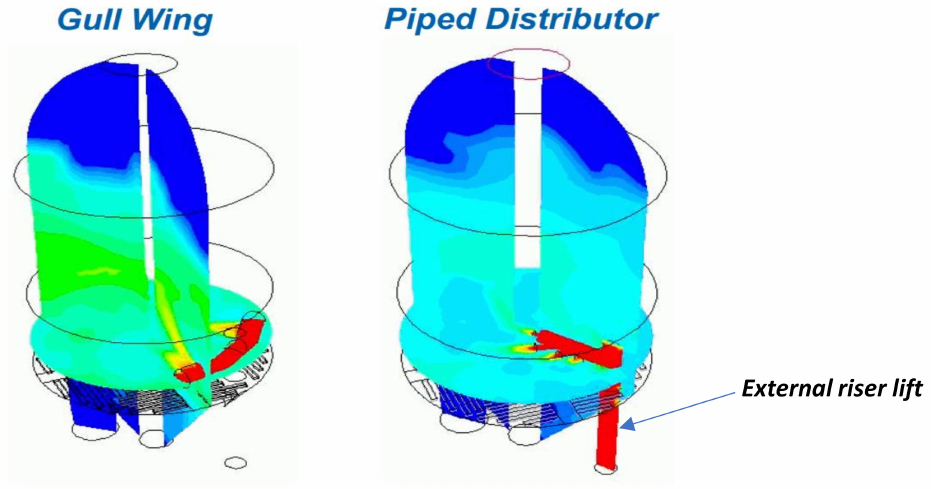
Figure 14. Spent catalyst density distribution by different spent catalyst distributors in FCC regenera- tor. Adapted from Wolschlag and Couch